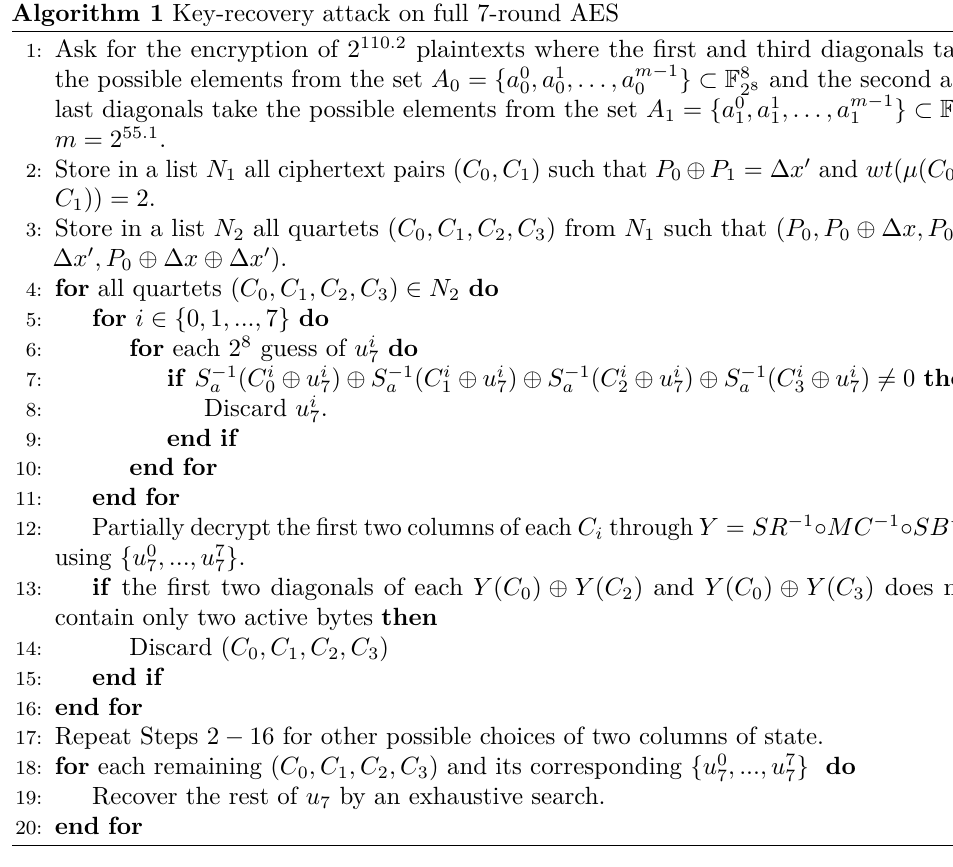
Algorithm 1 Key-recovery attack on full 7-round